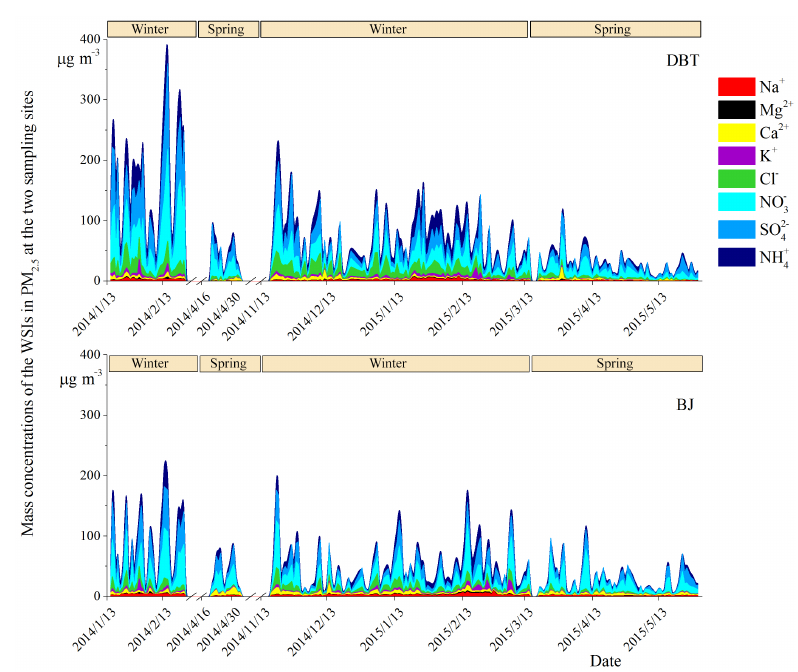
Figure 4. The mass concentrations of the WSIs in PM 2 . 5 at DBT and BJ during the sampling period in winter and spring of